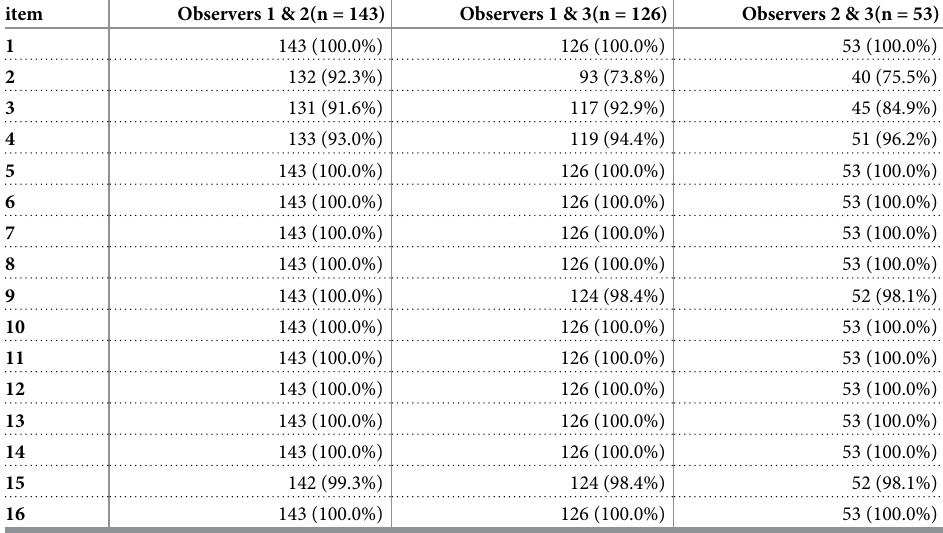
Table 2. First step of the assessment of observer agreement: Pairwise percent agreement on whether an item was discussed/available (i.e. rated “0” or